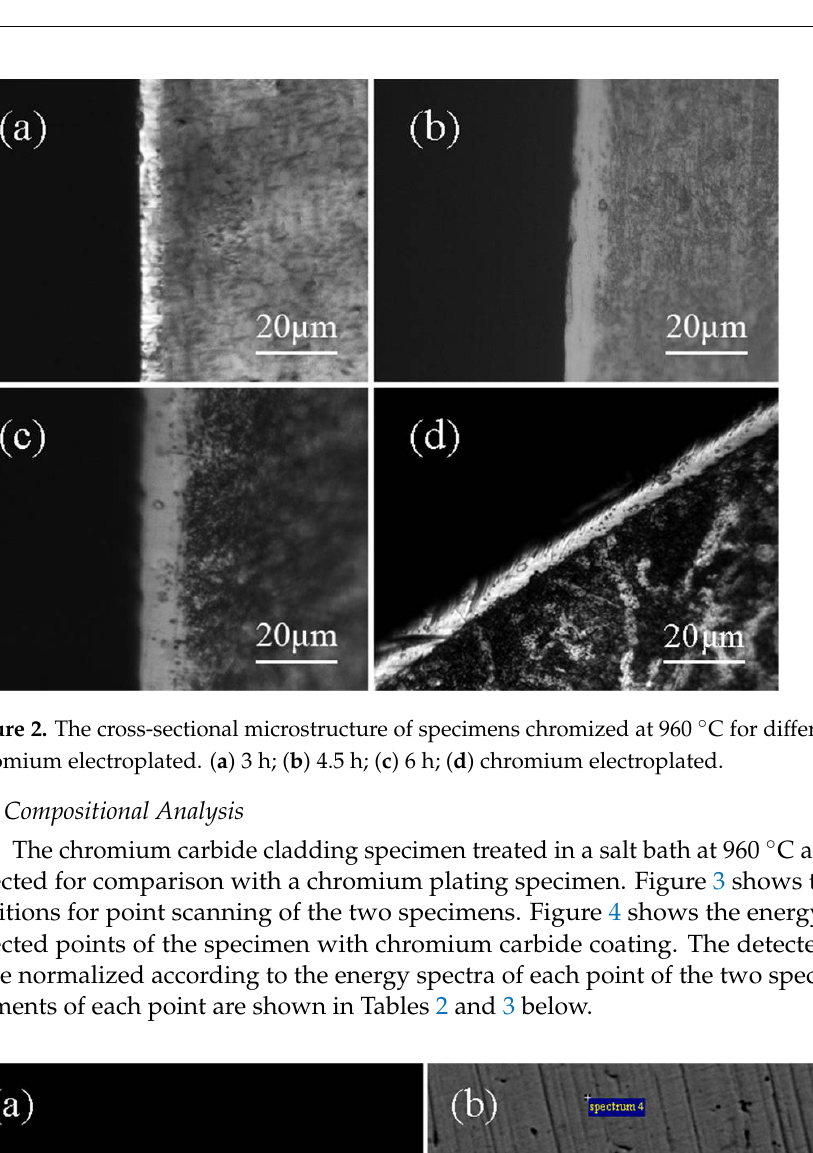
Figure 3. Electron probe microanalysis of chromium carbide and chromium plating coatings. ( a ) Chromium carbide coating; ( b ) Chromium plating coating.